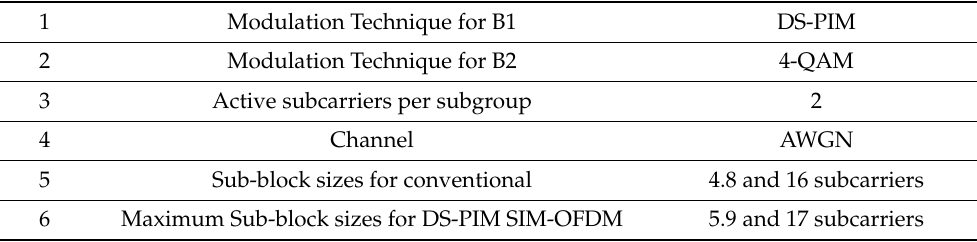
Table 5. Parameters used for Matlab